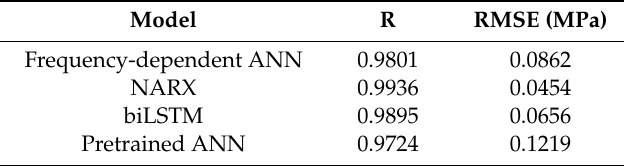
Table 4. Regression coe ffi cients and RMSE for the di ff erent ANN models on the NIRSpec data.